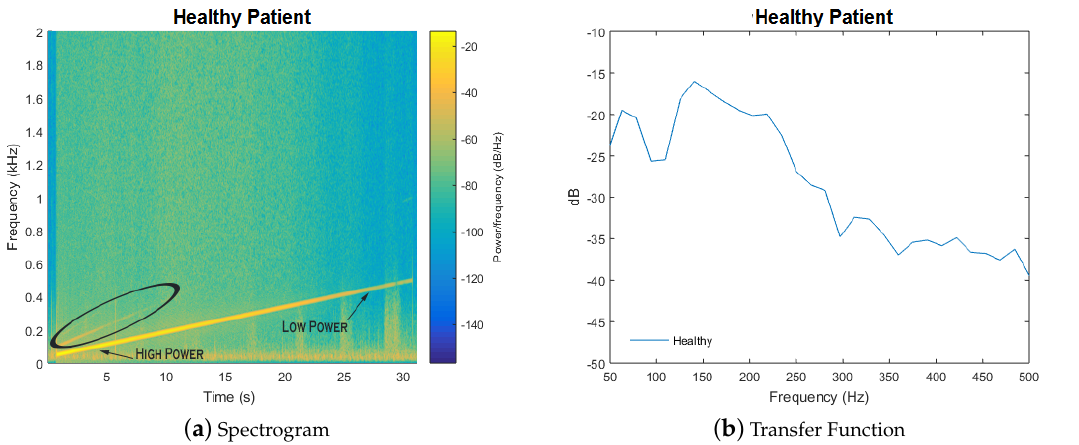
Figure 3. ( a ) spectrogram of a chirp signal applied to the chest of a healthy subject. Resonance is represented by a bright spot, as indicated by the arrow on the left side of the figure. Along the line of the chirp, a comparison to a less-bright spot is indicated on the right; harmonics are indicated by the non-parallel lines (circled) above the chirp; ( b ) plotting power values along the line of the chirp yields a plot of the transfer function. Figure from